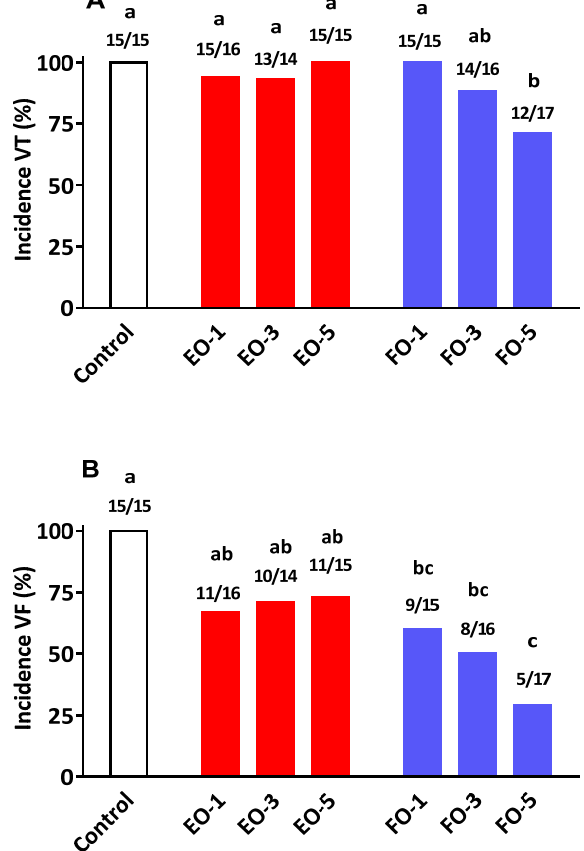
Figure 2. Percentage of incidence of ( A ) ventricular tachycardia (VT) and ( B ) ventricular fibrillation (VF) in rats fed standard laboratory diet (Control) or diet supplemented with Echium oil (EO, red ) or Fish oil (FO, blue ) at 1, 3 and 5 percentage ( w / w ). Numbers on top of the bars represent the incidence of VT or VF that occurred over the total number of animals measured. a, b, c Bars with different letters are significantly different ( p < 0.05).